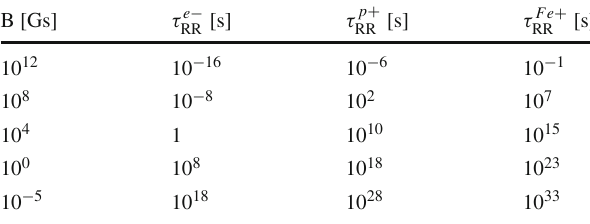
Table 4 Typical cooling times of electron τ e , proton τ p , and ionized ironatom(withoutoneelectron)fordifferentMFstrengths.Forcharged dust particles, the synchrotron cooling is irrelevant